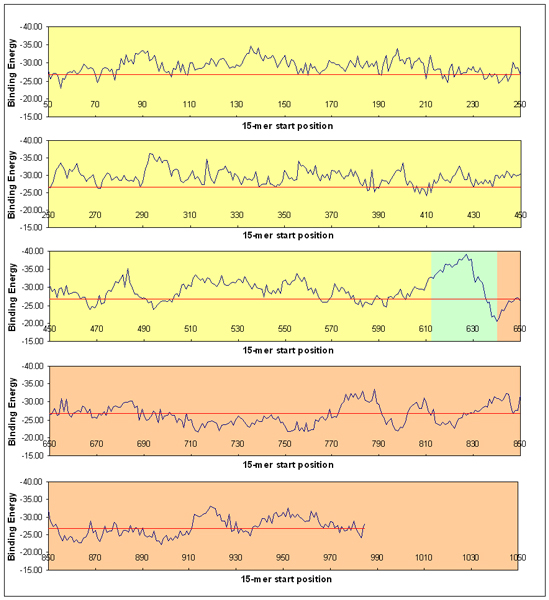
Predicted DQB1*0503-specific T-cell epitope repertoire within Dsg3. Location of predicted DQB1*0503-specific T-cell epitopes along the Dsg3 glycoprotein – extracellular domain (colored yellow; Dsg3 50–615), transmembrane region (colored green; Dsg3 616–640), and intracellular domain (colored pink; Dsg3 641–999). The red line indicates decision threshold -26.64 kJ/mol for high-affinity binders (SP = 0.80, SE = 0.65).